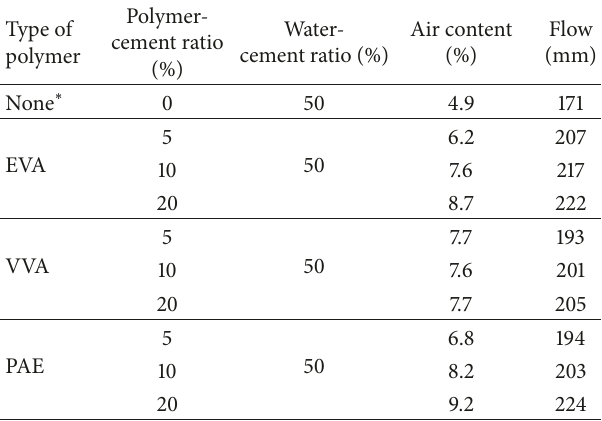
Table 3: Composition of PCM